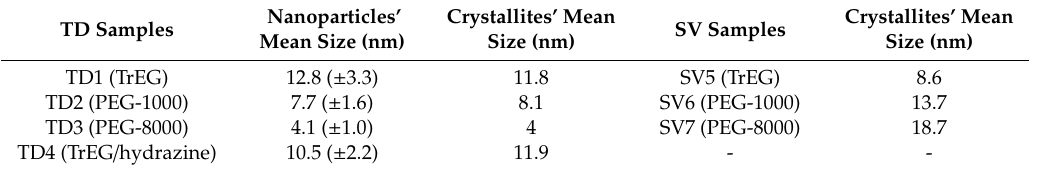
Table 3. The mean size values of the nanoparticles of samples TD1–TD4, as calculated by the TEM images, and the mean size values of the crystallites of all samples as calculated by Scherrer’s